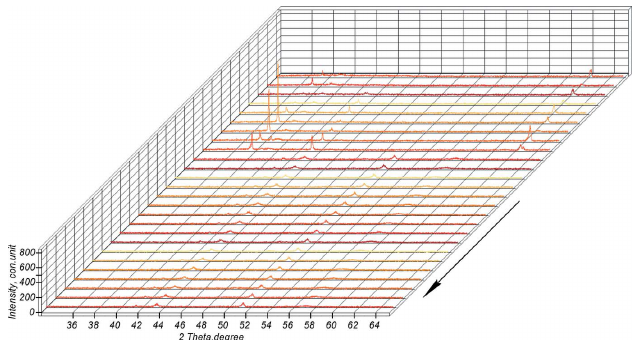
Figure 19 The system annealing section (the arrow indicates the direction of the